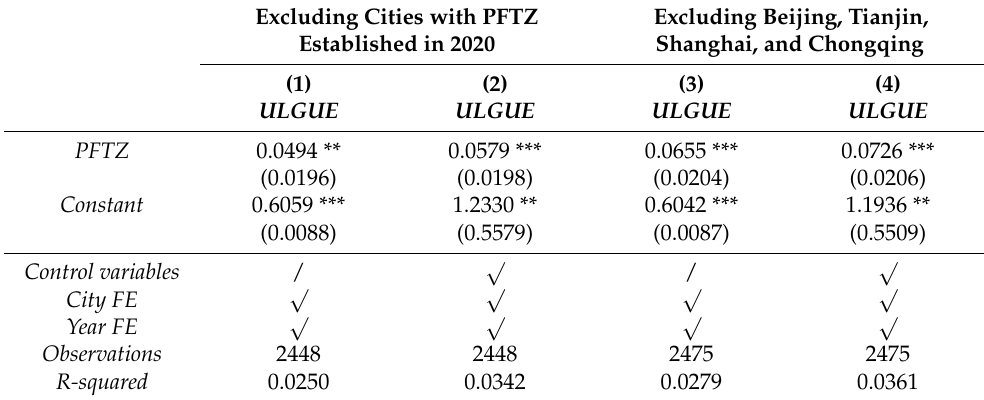
Table 6. Change the research sample.